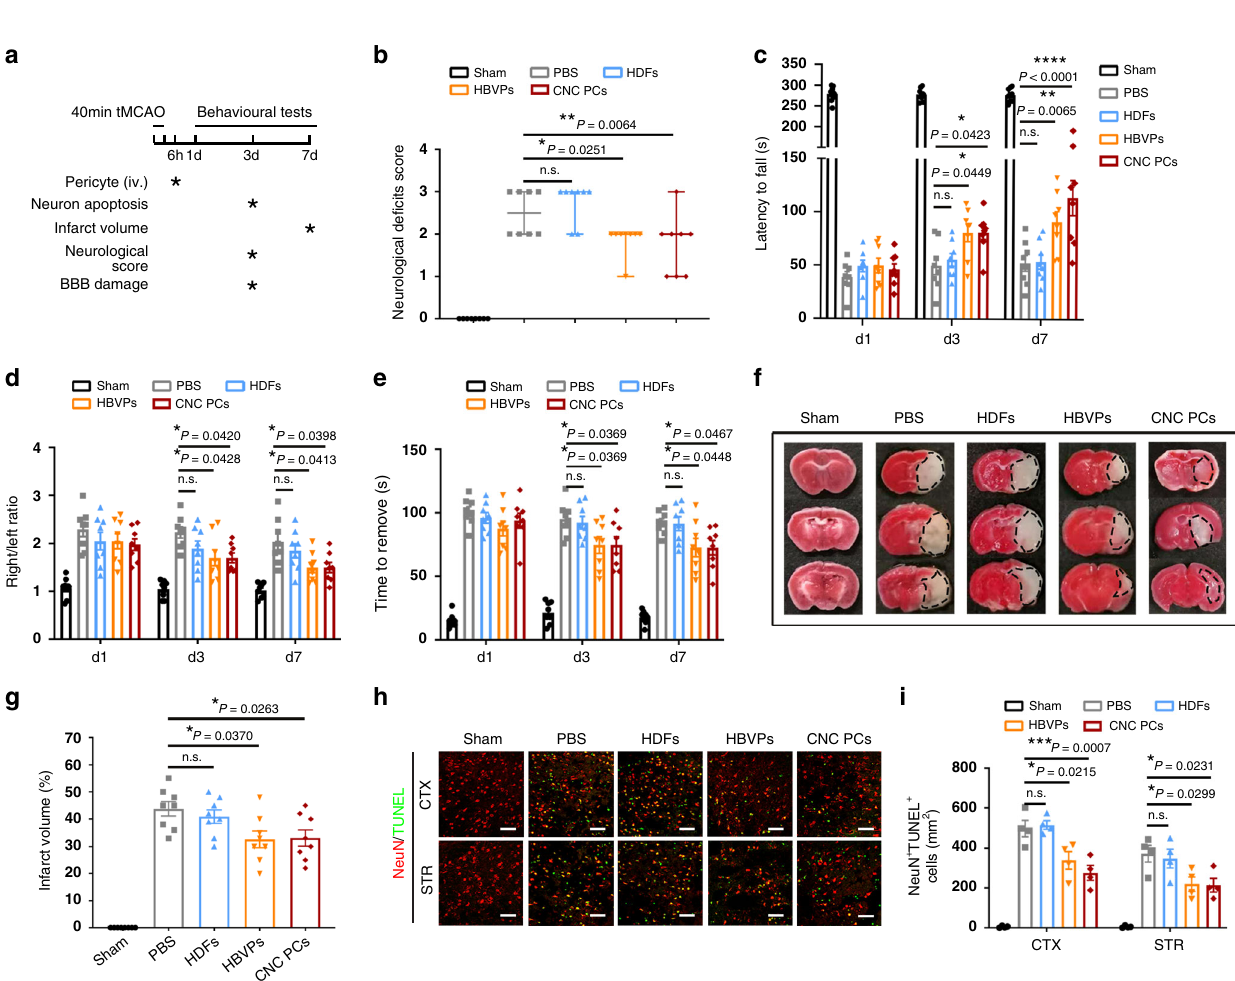
Fig. 6 Transplantation of hPSC-CNC PCs ameliorates brain injury and improves neurological functional recovery after ischemic stroke. a Scheme depicting the procedure of pericyte injection after stroke and the detection of neuronal apoptosis, neurological function and BBB damage. b Neurological de fi cit scores in different groups on day 3 were evaluated. c Motor coordination measurement from the rotarod test was rescued in tMCAO mice treated with HBVPs or CNC PCs. d The right/left ratio in the corner test at different time points was calculated. e The time to remove the sticker in the adhesive removal test at different time points was analyzed. f Representative TTC-stained coronal sections in different groups. g Infarct volumes of different groups were determined at 7 days post stroke and quanti fi ed on TTC (red)-stained coronal cerebral sections. h Fluorescent staining with NeuN (red) and TUNEL (green) showed neuronal apoptosis in the cortex and striatum at day 3 after transplantation. Scale bar: 100 μ m. i The bar graph shows the quanti fi cation of the percentage of TUNEL + neurons in different groups. Graphs represent the individual data points, and data are presented as median ± 95% CI ( b ) or mean ± SEM ( c , d , e , g , i ). Behavior tests and infarct volume analysis are derived from n = 8 ( b , c , d , e , f , g ) biologically independent animals and confocal images are representative of n = 4 ( h , i ) independent animals. P- value (* P < 0.05, ** P < 0.01, *** P < 0.001, **** P < 0.0001) was calculated by one-way ( b , g ) or two-way ANOVA with Tukey post hoc test for multiple comparisons ( c , d , e , i ). Source data are provided as a Source Data fi transcytosis within the brain endothelium following tMCAO by ipsilateral hemisphere (Fig. 7c). Similar results were obtained in the fl uorescent-dextran assay (Fig. 7d) and the measurement of fi bri- transmission electron microscopy (TEM) 34 . Compared to the sham nogen/albumin deposits (Fig. 7e). We also tried to examine whether group, the average number of caveolae in each TEM image was the transplantation of HBVPs or hPSC-CNC PCs suppressed much higher in the PBS and HDF groups after tMCAO.